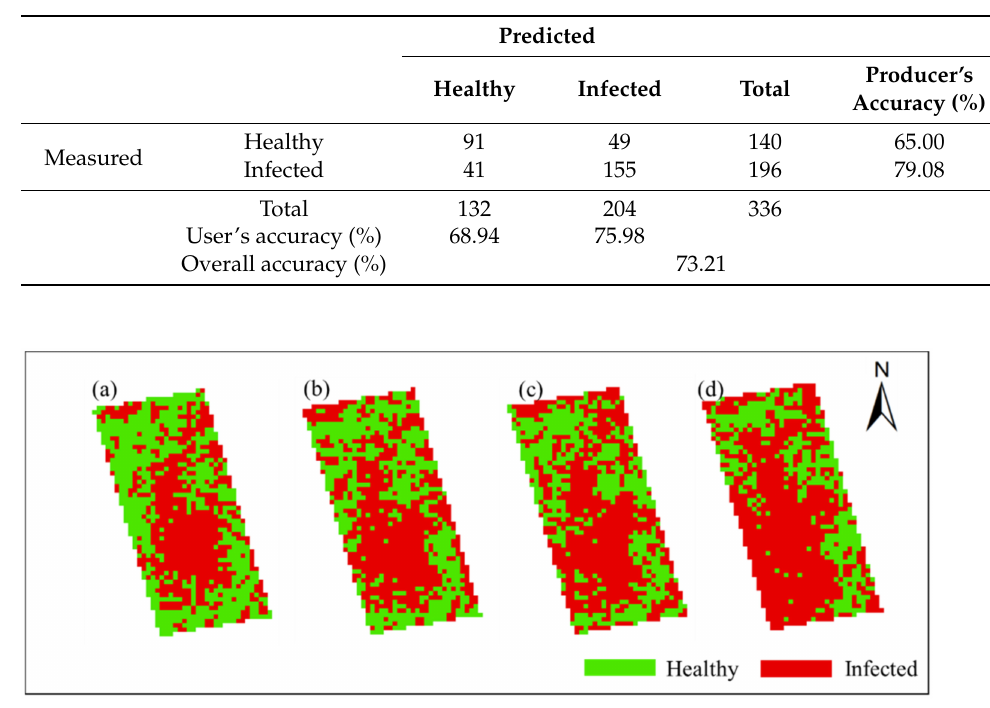
Table 7. Results of Method-SSA on 2 September 2020.